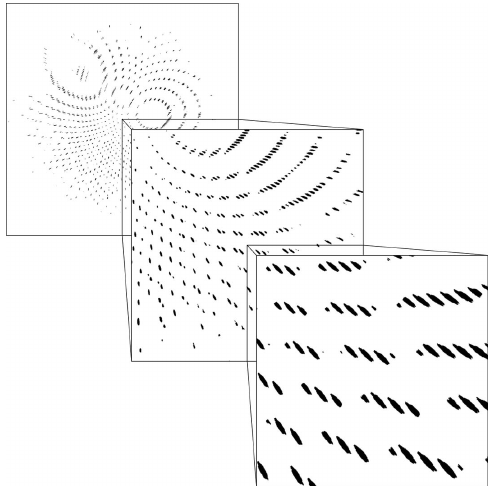
Figure 5 Simulated snapshot diffraction patterns from a randomly oriented crystal of the 5-HT 2B receptor (PDB entry 4nc3) with mosaicity of 0.2 (cid:5) . The simulations were performed with an X-ray BW of 3.5% (top-hat shape), photon energy of 4.5 keVand experimental geometry similar to the SFX setup at the Alvra end station at SwissFEL with the JUNGFRAU 16M detector. The resolution at the edge of the image is 2.6 A˚